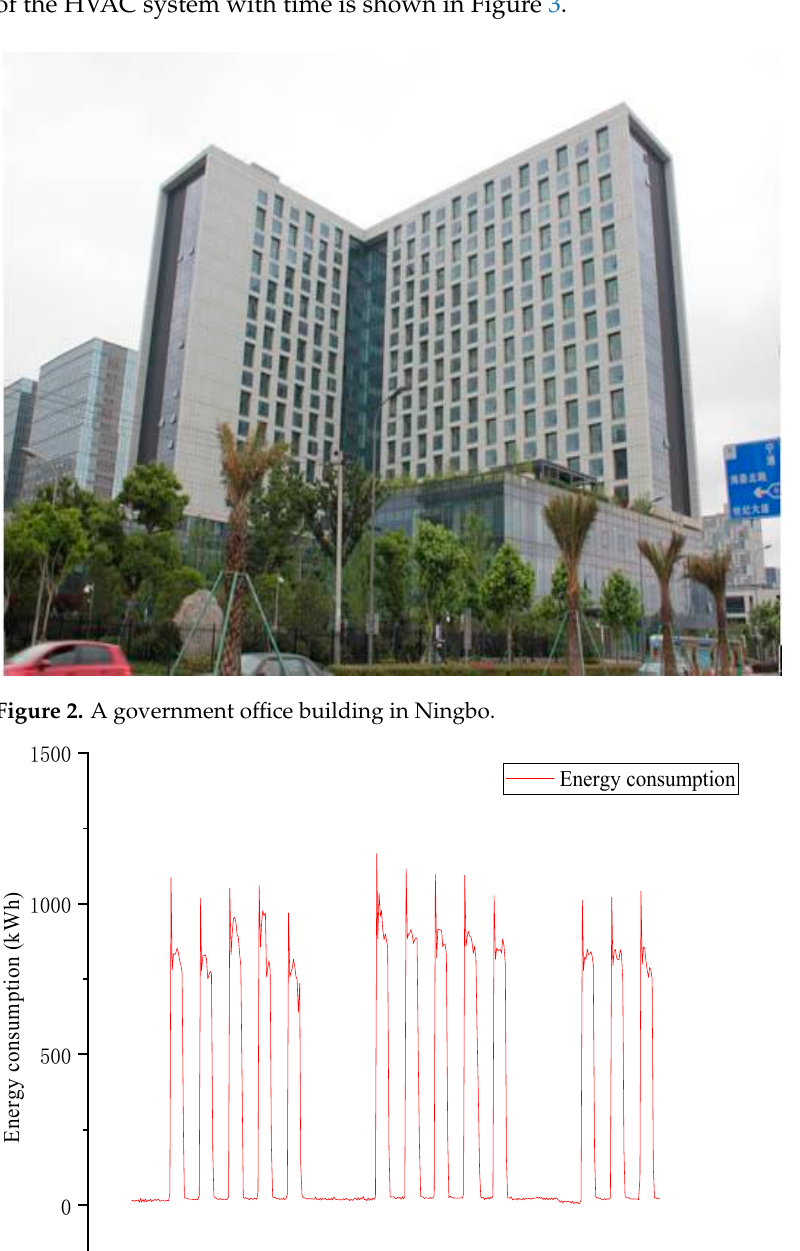
Figure 2. A government office building in Ningbo .